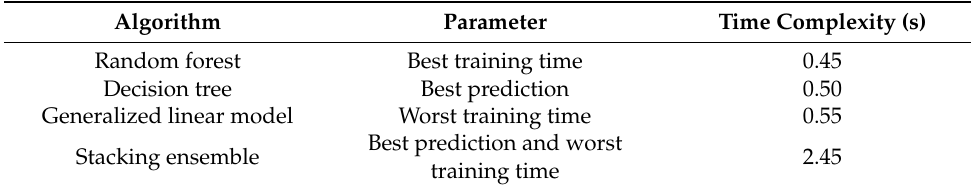
Table 2. Time complexity of the machine learning